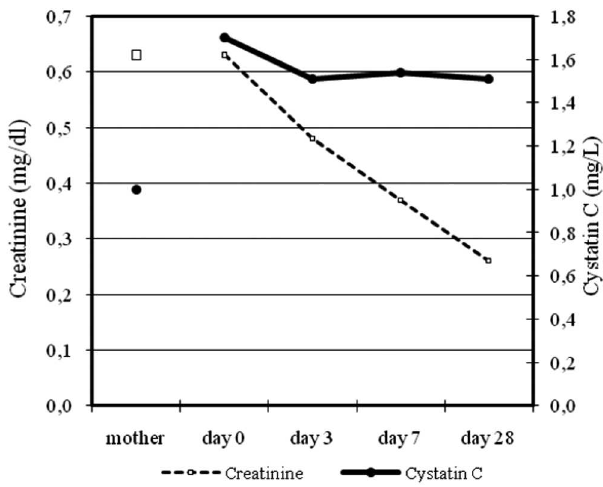
Figure 2 - Mean values of mother creatinine and cistatina C at birth and the newborn during the 1 st month